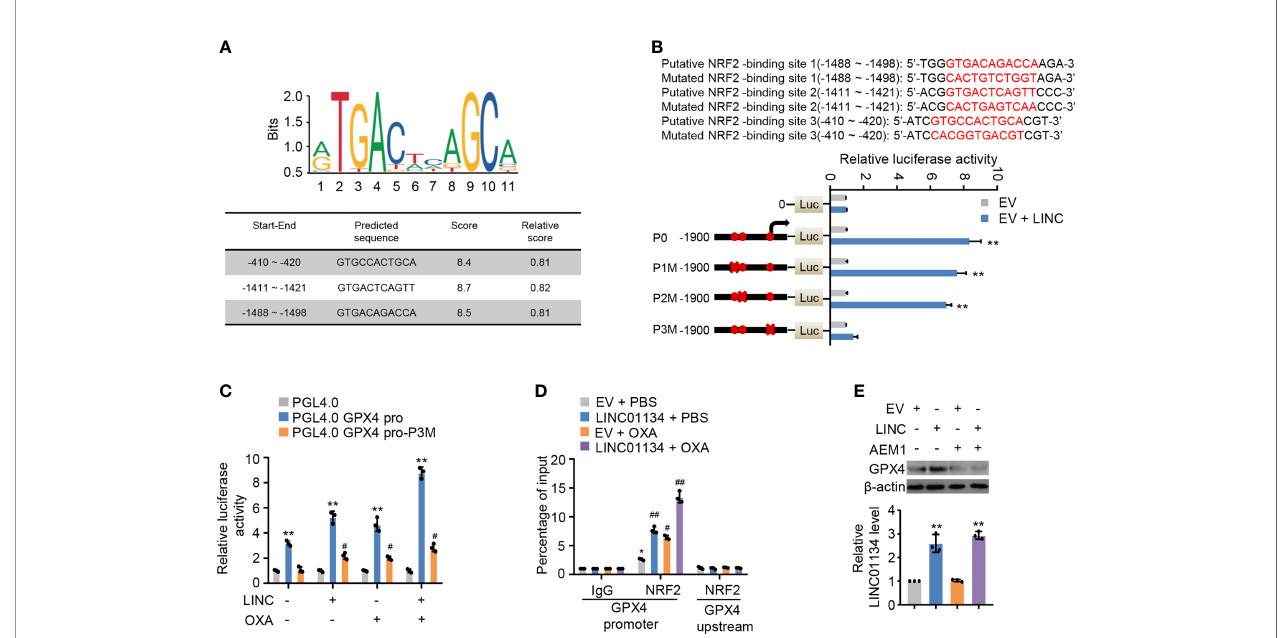
FIGURE 4 | LINC01134 promotes GPX4 expression through Nrf2 transcription. (A) Motif analysis of Nrf2 binding peaks to GPX4 promoter sequence according to JASPER website (http://jaspar.genereg.net/). (B) Luciferase activity of different segmented GPX4 promoters of HepG2 cells transfected with indicated plasmids. Solid circles indicate the putative location of the Nrf2 binding sites, and the “ X ” indicates the mutated Nrf2 binding sites. The red letters in each bound area show the putative or mutated Nrf2 binding sequences. (C) Luciferase assays for the selected GPX4 promoter reporters from (A) transfected with LINC01134 and treated or not with OXA. (D) ChIP analysis for Nrf2 occupancy on the GPX4 the promoter upstream or promoter in HepG2 cells transfected with LINC01134 and treated or not with OXA. (E) Representative immunoblots indicate the GPX4 expression in HepG2 cells transfected with EV or LINC01134 and treated with AEM1 (5 m M, 1 day). The histogram indicates the LINC01134 expression in HepG2 cells. All data are presented as Mean ± SD.; two-tailed unpaired Student ’ s t-test: *P < 0.05, **P < 0.01, # P < 0.05, ## P <